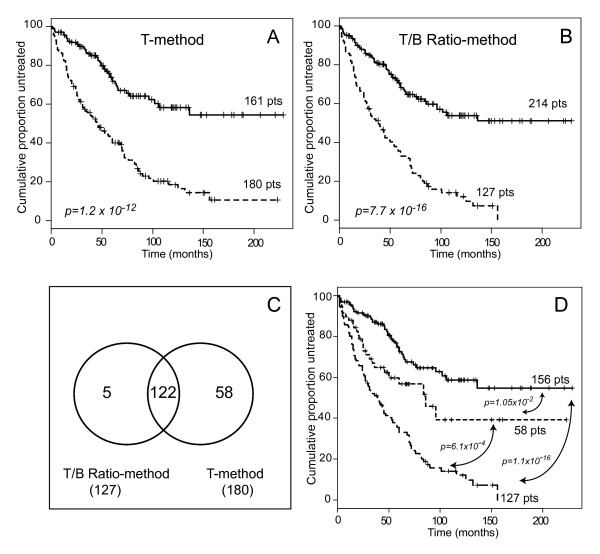
ZAP-70 expression in the validation set. (A-B) Kaplan-Meier curves obtained comparing TTT of patients affected by CLL expressing ZAP-70 according to T-method (A) or T/B Ratio-method (B). In all plots solid line indicates ZAP-70 negative CLL, while dashed line indicates ZAP-70 positive CLL. (C) Venn diagram depicting concordant and discordant cases, as obtained by merging the ZAP-70 positive cases determined by the two readouts. (D) Kaplan-Meyer curves obtained comparing TTT of patients affected by CLL expressing ZAP-70 according to T/B Ratio-method (127 cases), expressing ZAP-70 according to sole T-method (58 cases), or ZAP-70 negative according to both methods (156 cases).